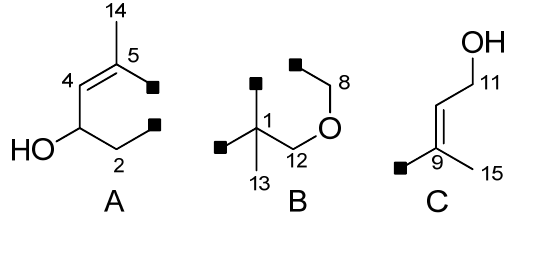
Figure 2. Key COSY and HMBC correlations for apocarotenoid 2